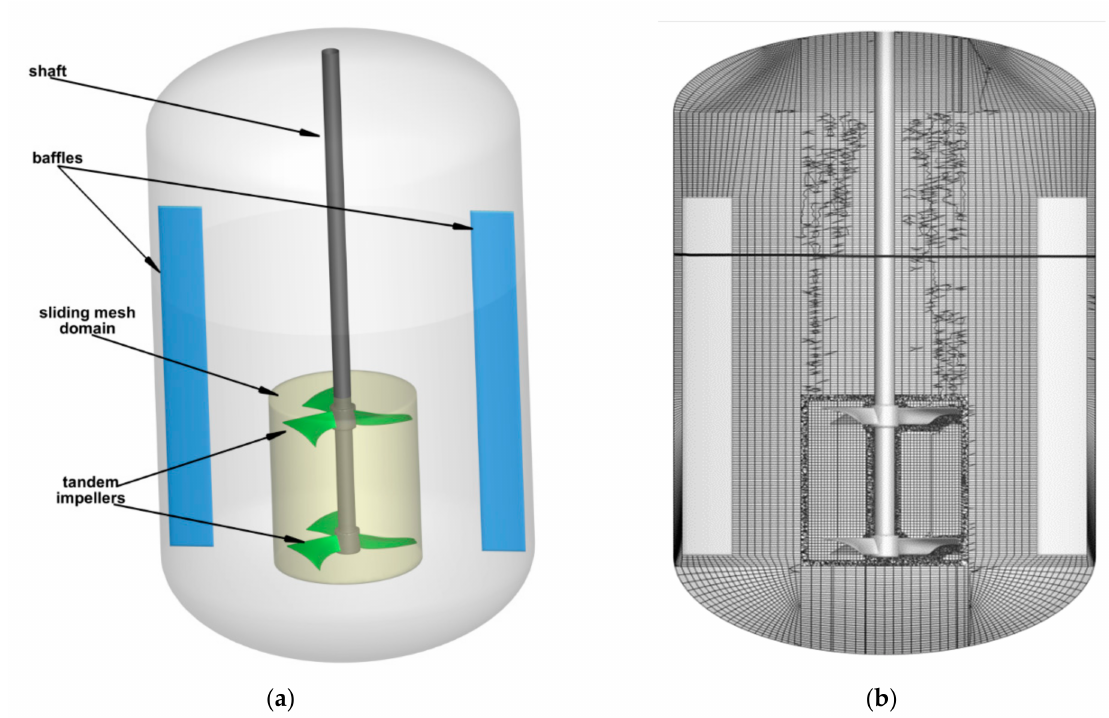
Figure 2. Computational domain: ( a ) components of the reactor; ( b ) mesh of the computational